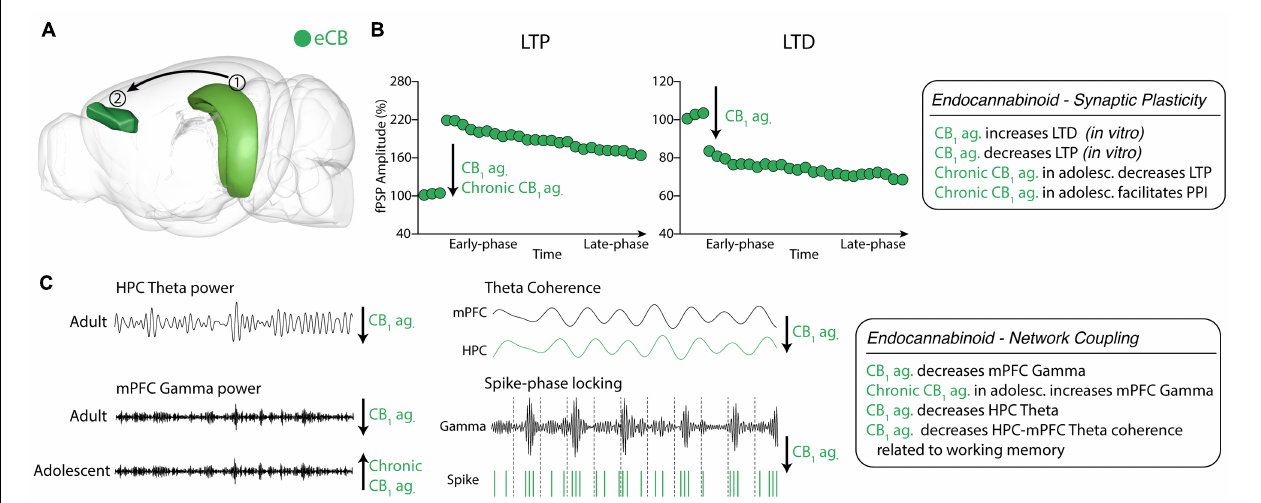
FIGURE 4 | Endocannabinoid neuromodulation of HPC-mPFC communication (A) eCB system in HPC and mPFC areas. (1) Hippocampus CA1; (2) Prelimbic prefrontal cortex. Green: eCB neurotransmission in HPC and mPFC (brain sites adapted from the Brain Explorer, Allen Institute). (B) CB 1 activation decreased LTP maintenance in HPC-mPFC pathway. (C) CB 1 agonism reduces HPC theta power and decreases mPFC Gamma power in adults, while chronic CB 1 agonist treatment during adolescence increased mPFC Gamma power in adults. Also, CB 1 agonism decreases HPC-mPFC theta coherence during a spatial working memory task and spike-gamma band phase locking in mPFC. eCB, endocannabinoid; LTP, CB 1 , cannabinoid receptor 1; long-term potentiation; LTD, long-term depression. ag, agonist; ant.,